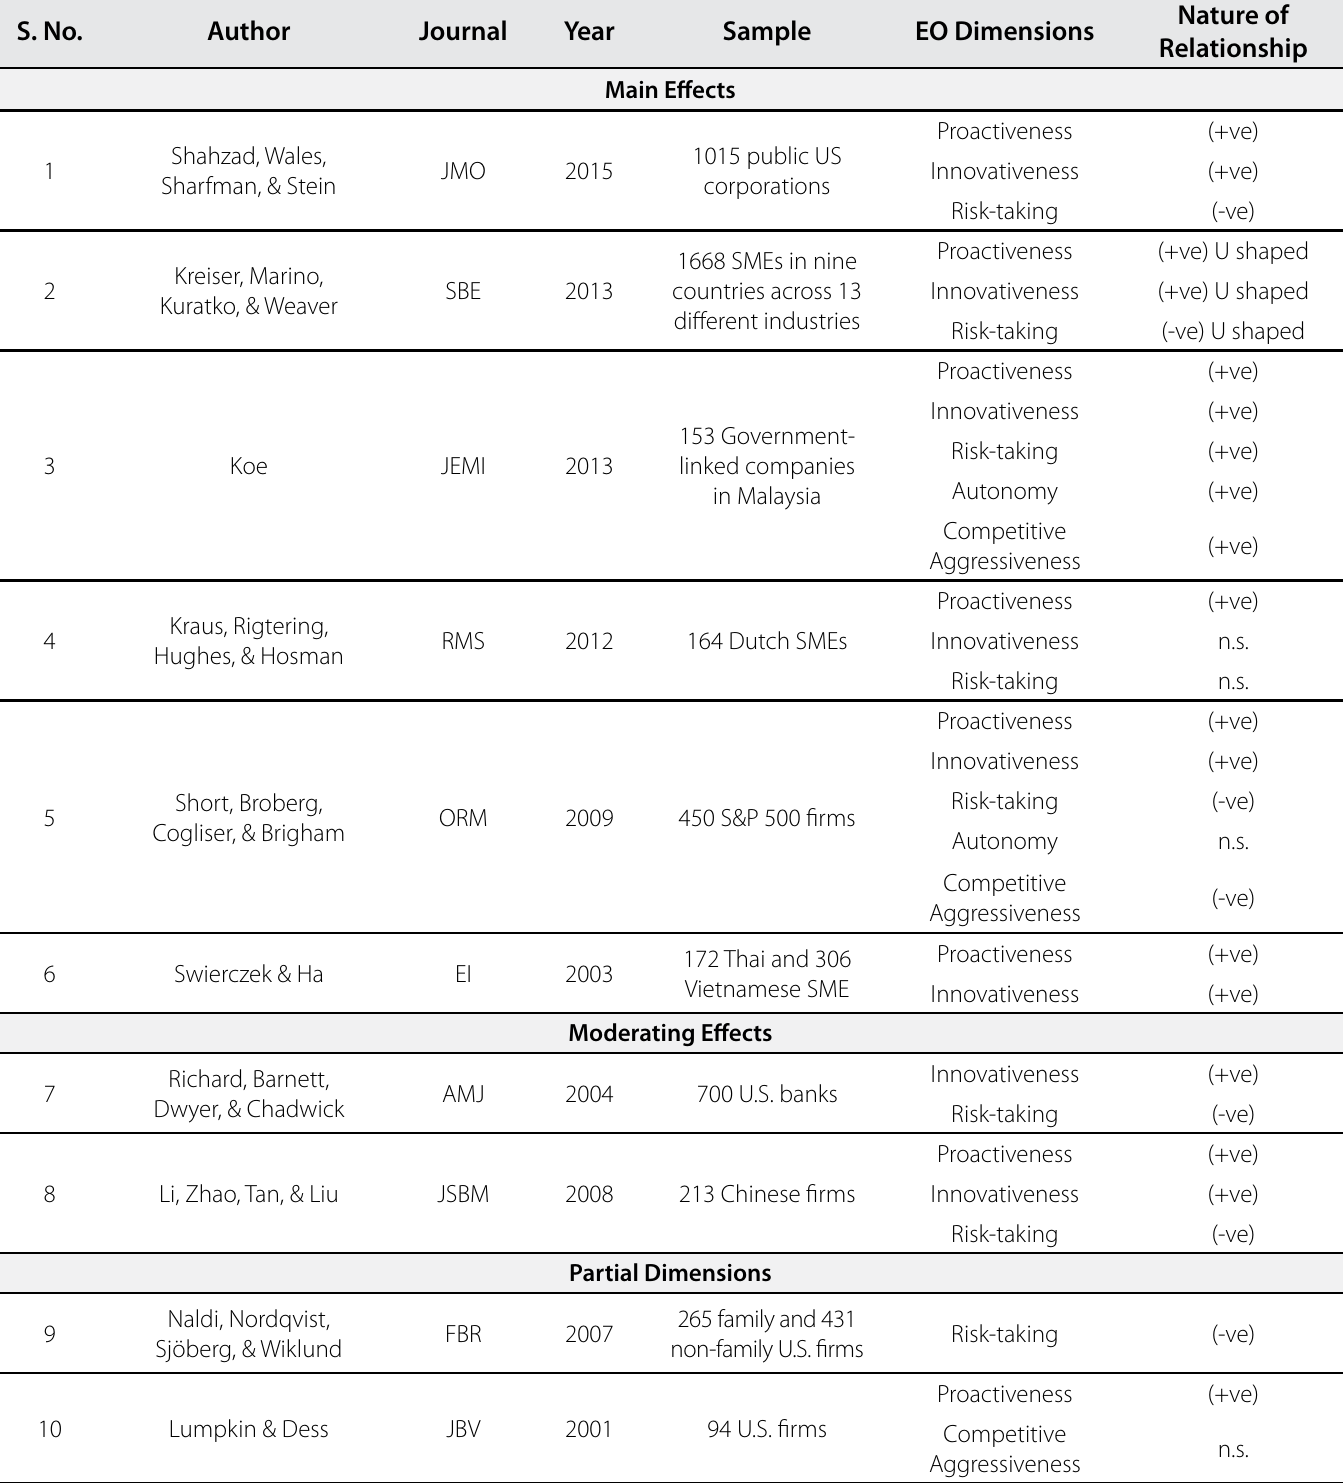
Table 1. Articles Examining Relationship between Different Dimensions of Entrepreneurial Orientation and Firm